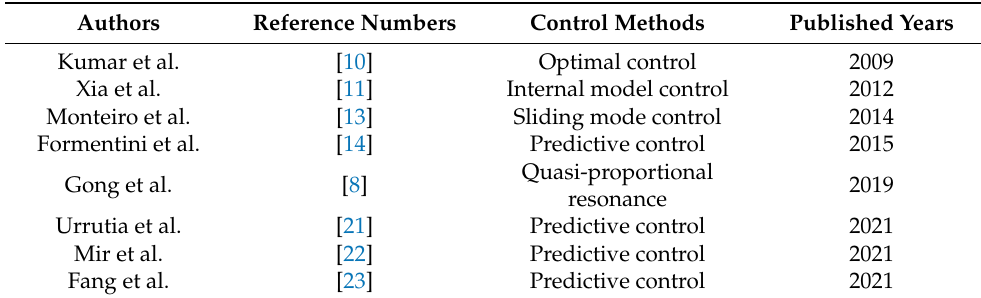
Table 1. Main control methods of matrix converter-based AC